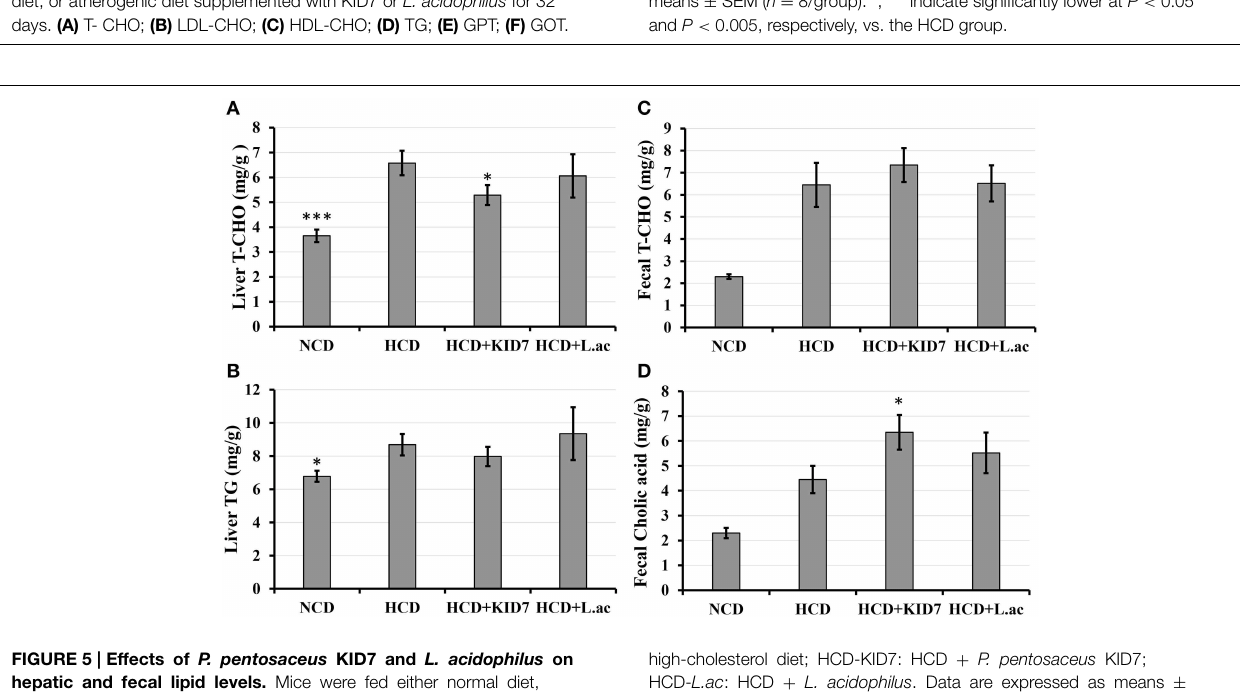
high-cholesterol diet; HCD-KID7: HCD + P. pentosaceus KID7; HCD- L.ac : HCD + L. acidophilus . Data are expressed as means ± SEM ( n = 8 /group). * , *** indicate significantly different (lower for A and B , higher for C and D ) at P < 0 . 05 and P < 0 . 005 , respectively, vs. the HCD